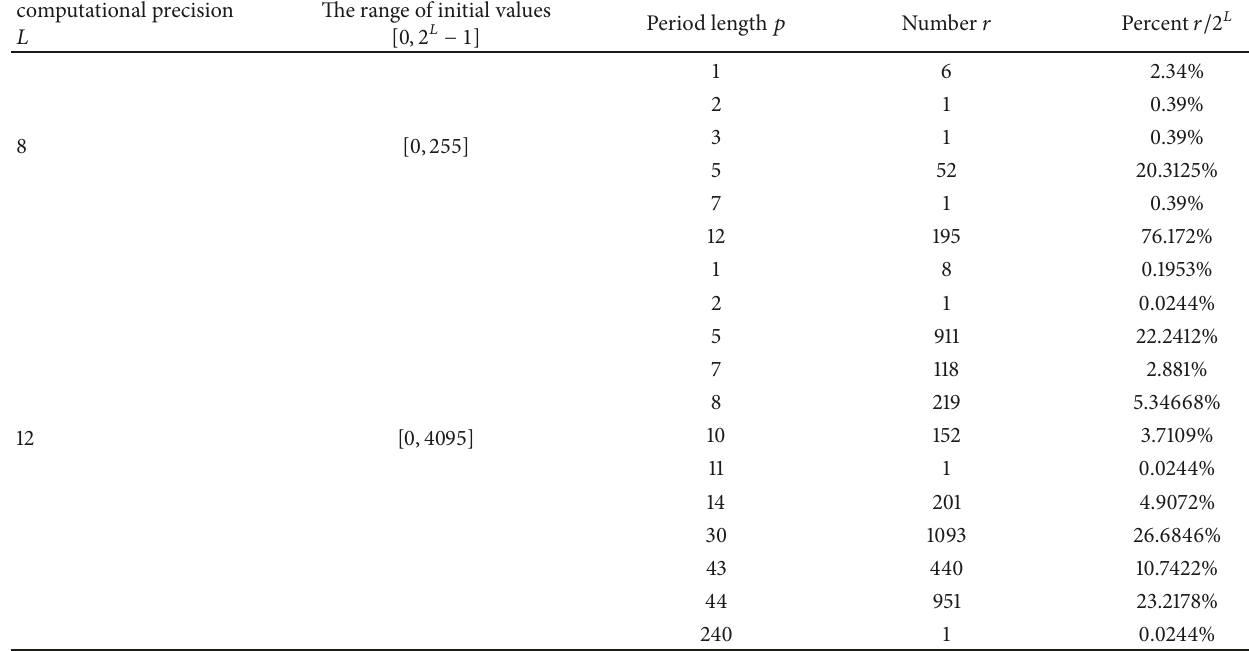
Table 3: The statistical analysis of Tent sequence periodicity with different computational precision. computational precision